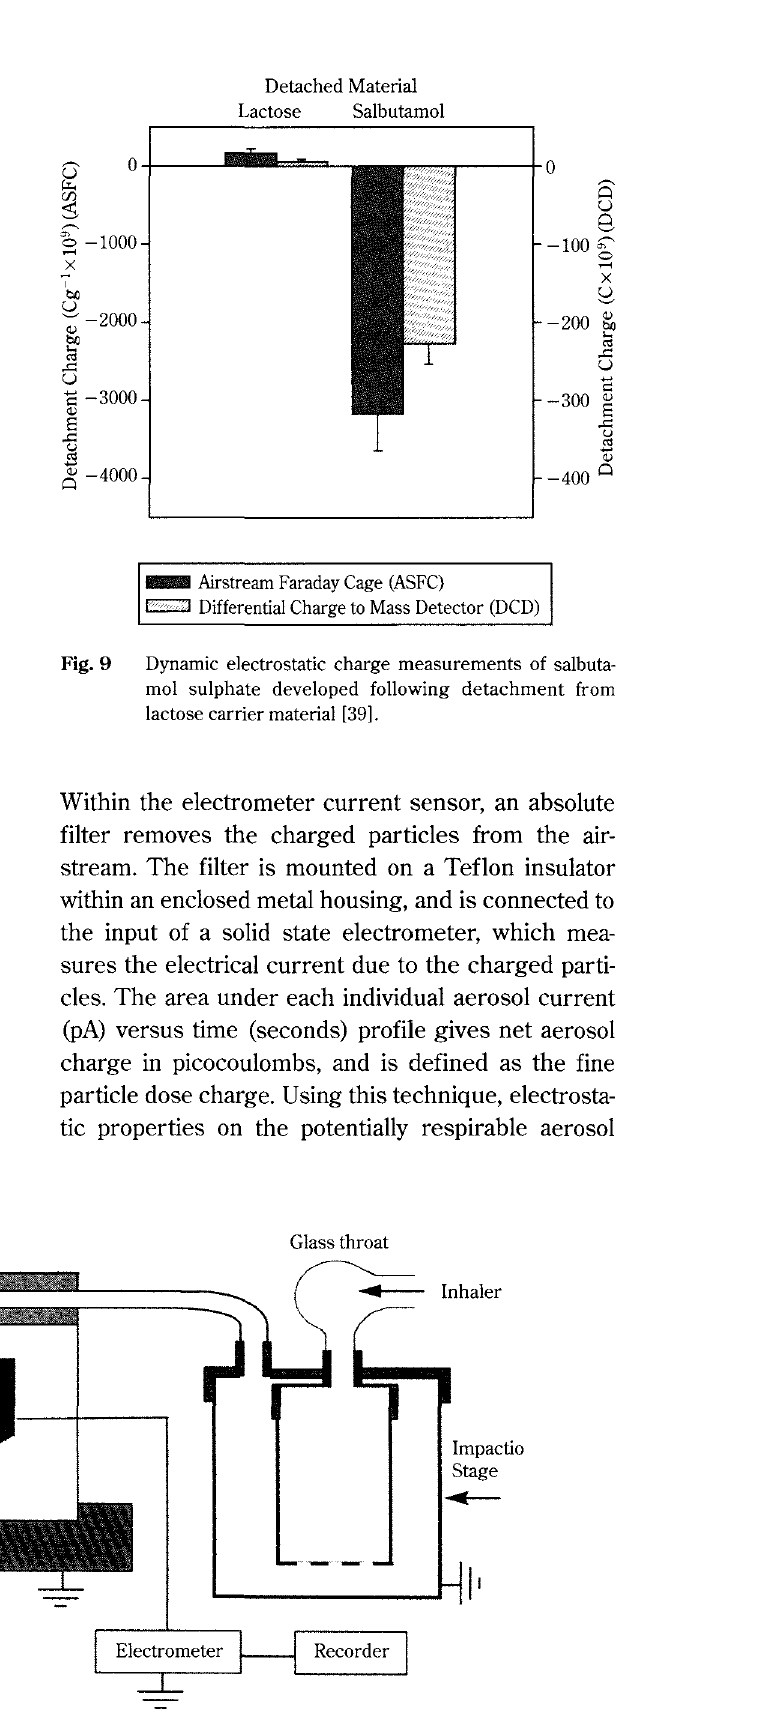
Fig. 10 Diagrammatic representation of aerosol sampling apparatus for the aerosol electrometer [37].